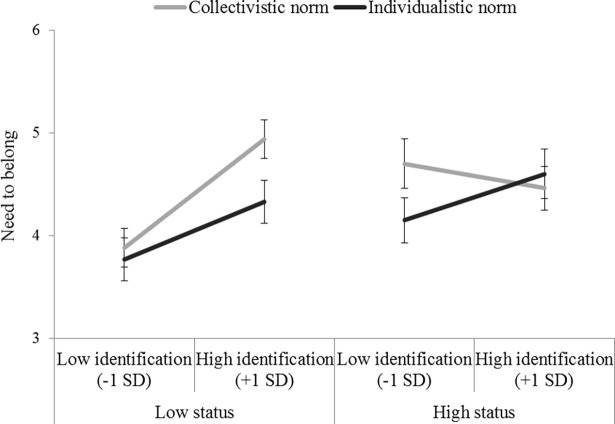
Means of need to belong according to ingroup identification, norm and status (Study 3).Error bars represents ±1 SE.